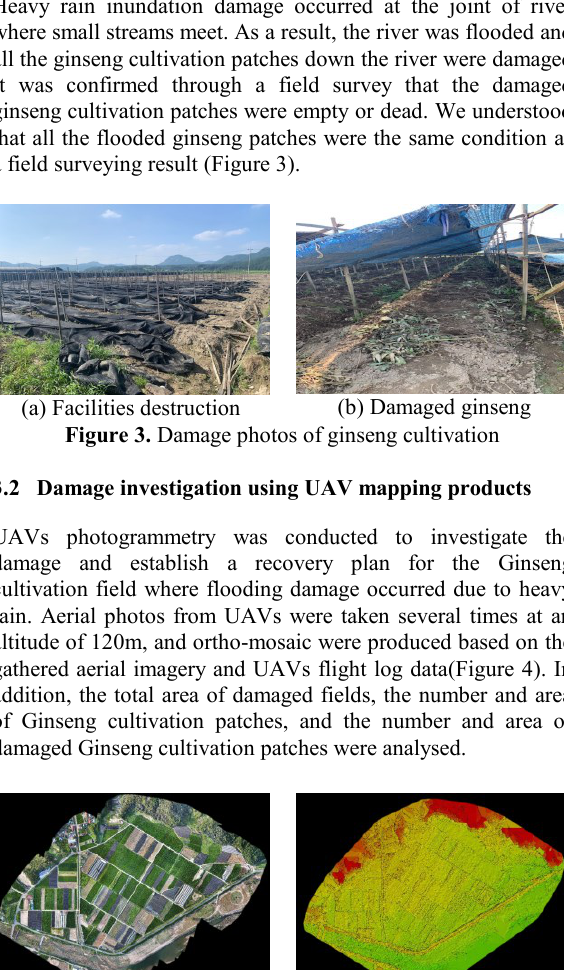
Figure 4. Final products by UAV mapping at flooded